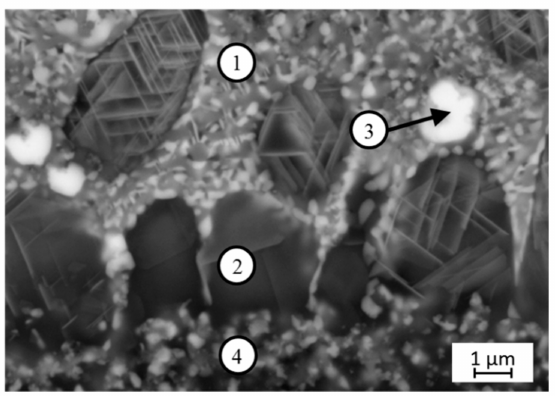
Figure 2. Braze seam of area marked in Figure 1, 1: ternary eutectic microstructure, 2: primary solidified Al-rich solid solution, 3: primary solidified Al-Ag-rich solid solution, 4: ternary eutectic microstructure [29]. Table 2. Chemical compositions (energy dispersive X-ray spectroscopy (EDXS)) of phases and detected phases (X-ray diffraction analysis (XRD)) in braze filler B-Al40Ag40Cu20 wetted on aluminium